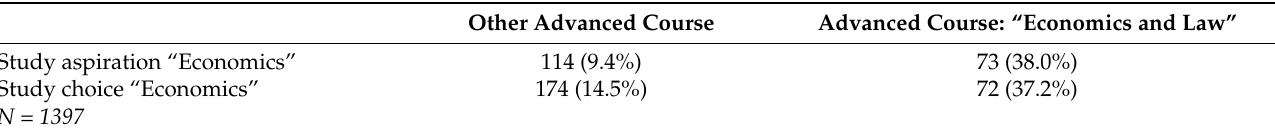
Table 8. Advanced school course and study